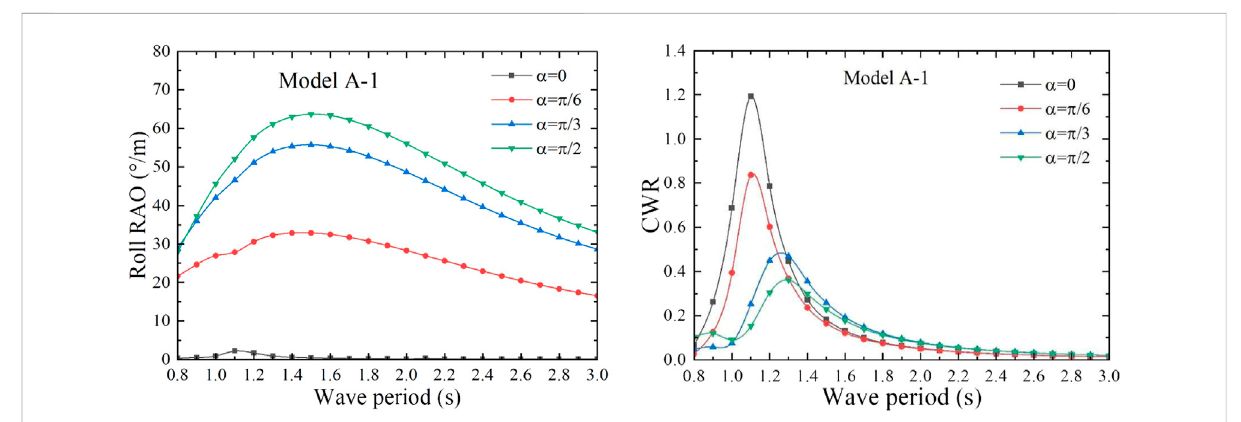
FIGURE 6 Roll RAO and the CWR of model A-1 with different incident wave angles α